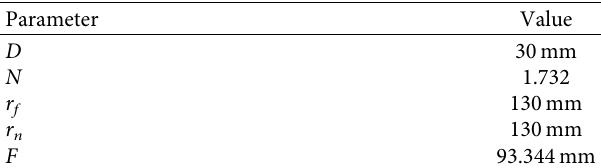
Figure 8: Structure of lens. Table 3: Spherical lens